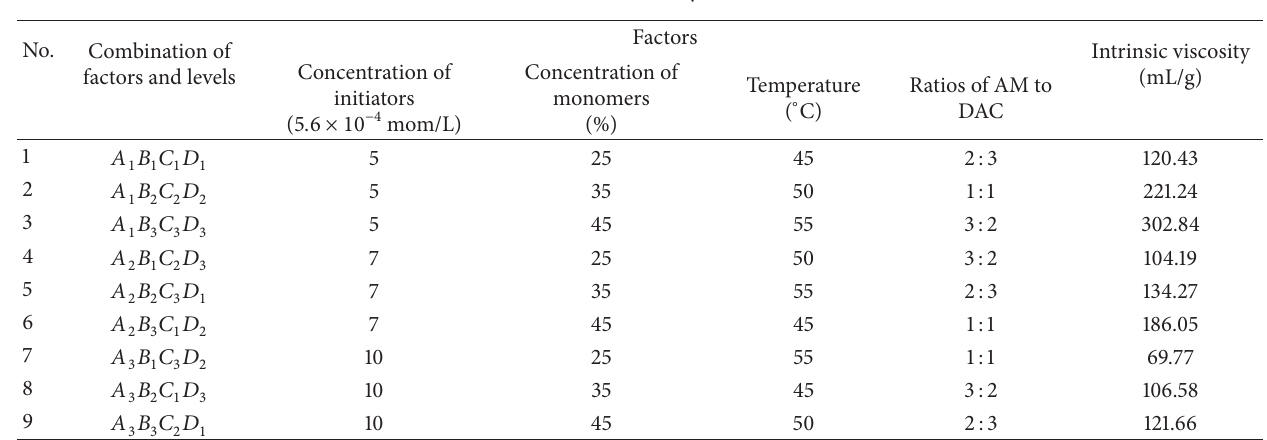
Table 2: Results of synthesis.